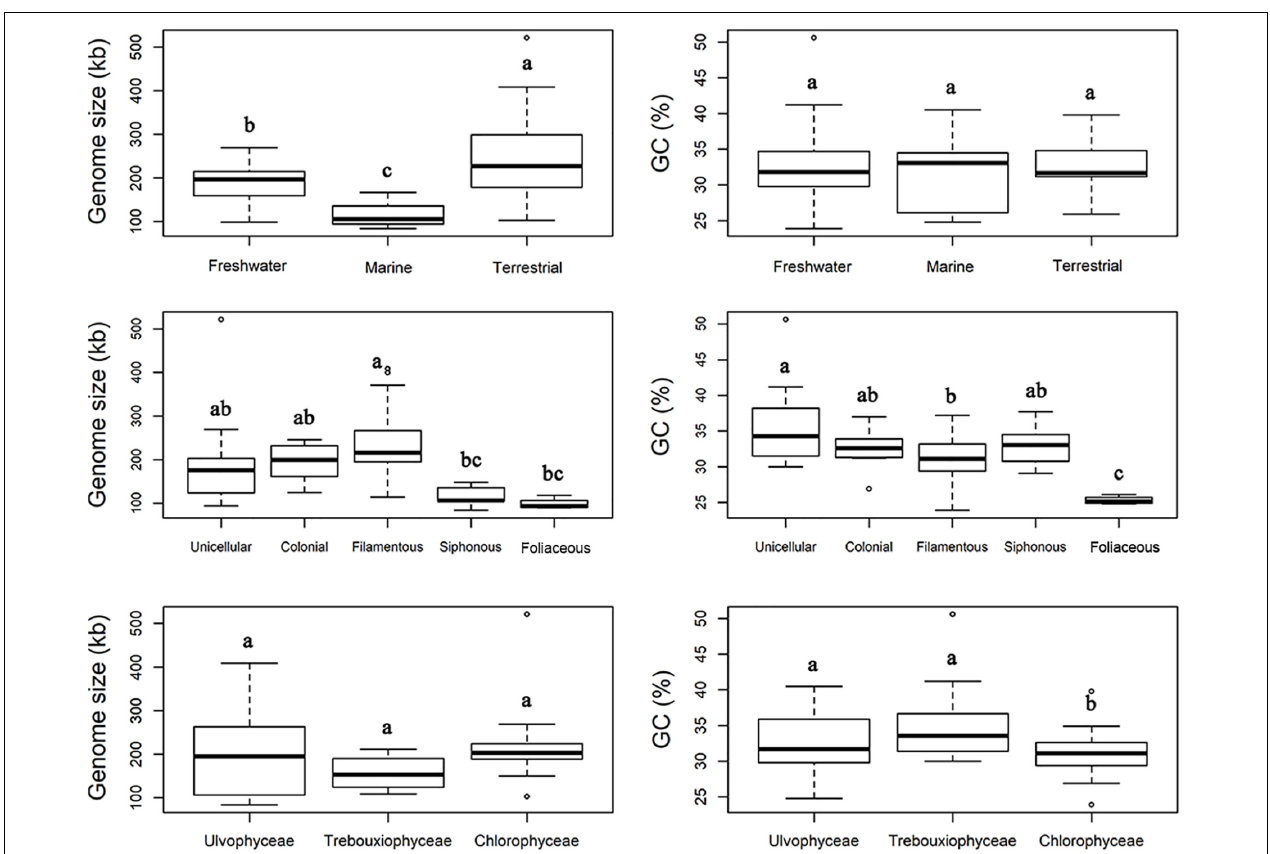
FIGURE 3 | Comparison of chloroplast genome size and GC content of Chlorophyta from different habitats (top), diverse functional morphology (middle), and taxonomic classes (bottom). The common letters above boxplots represent insignificant differences of variables (e.g., a and ab; ab and b), the different letters above boxplots represent significant differences variables (e.g., a and b; b and